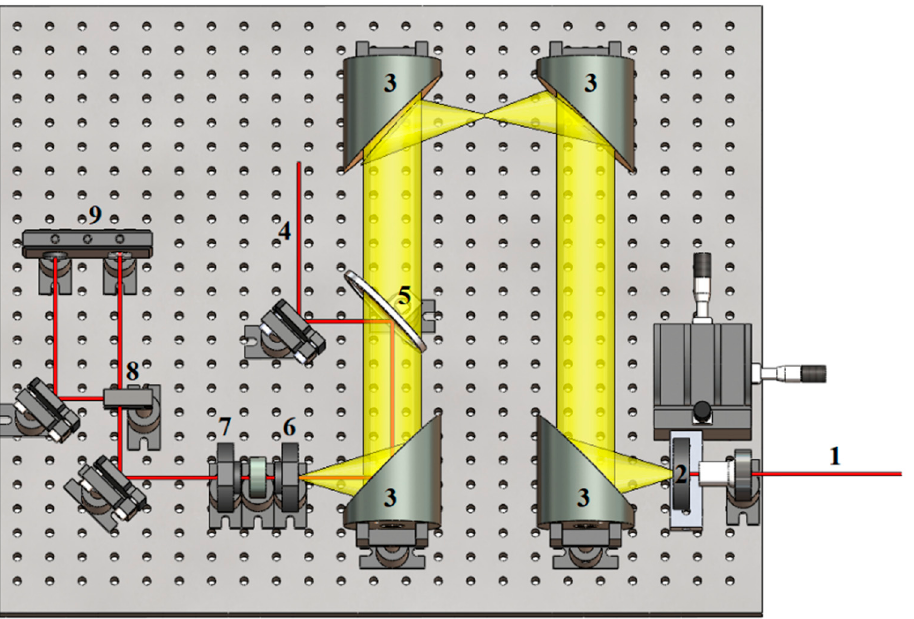
Figure 3. Illustration of THz-TDS used to characterize the PC THz emitter, pump beam (1) is focused onto the PC THz emitter (2), the generated THz beam (yellow) is focused and steered via parapolice mirror-(3). The probe beam (4, red) is overlapped with the THz beam via pellicle beam-splitter (5), modulated via electro-optic crystal (6) and quarter waveplate (7), separated by a polarizing beam-splitter (8) into two orthogonal polarizations beams, and the power difference between these two beams is measured by a differential photodetector (9).